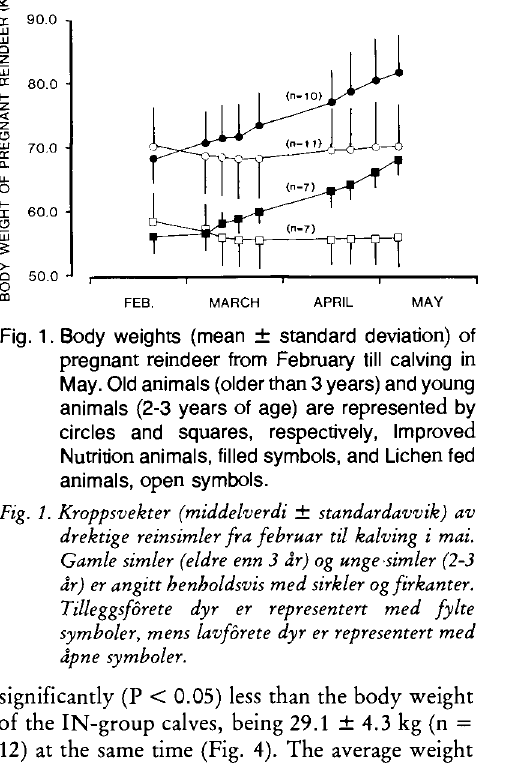
Fig. 1. Body weights (mean ± standard deviation) of pregnant reindeer from February till calving in May. Old animals (older than 3 years) and young animals (2-3 years of age) are represented by circles and squares, respectively, Improved Nutrition animals, filled symbols, and Lichen fed animals, open symbols. Fig. 1. Kroppsvekter (middelverdi ± standardavvik) av drektige reinsimler fra februar til kalving i mai. Gamle simler (eldre enn 3 år) og unge simler (2-3 år) er angitt henholdsvis med sirkler og firkanter. Tilleggsforete dyr er representert med fylte symboler, mens lavforete dyr er representert med åpne symboler.